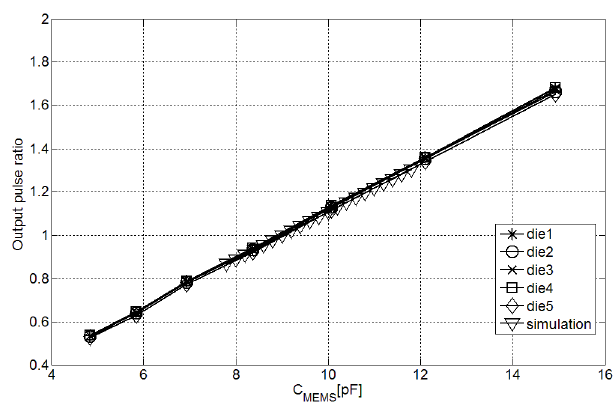
Figure 6. Output ratio in the fabricated interfaces with different C